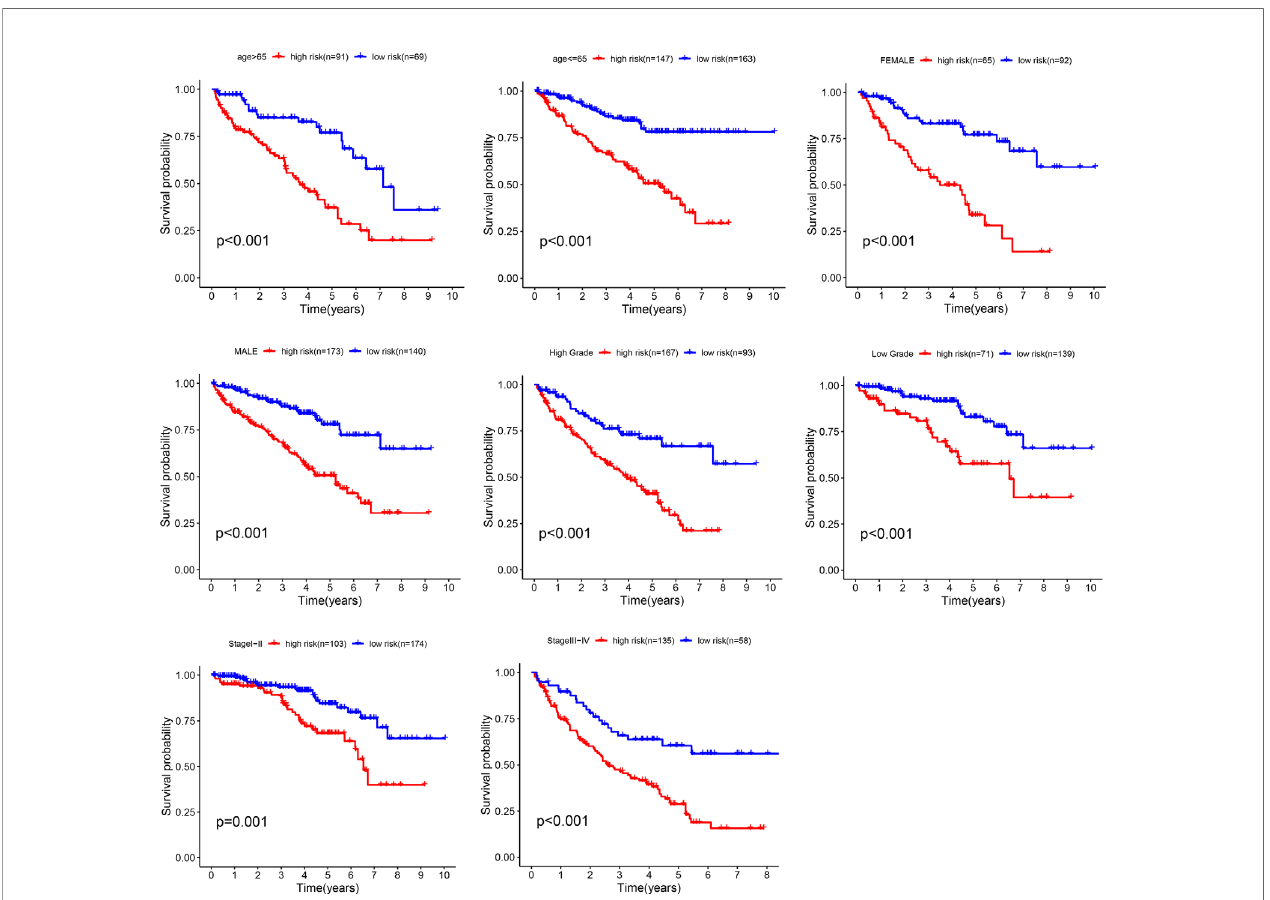
FIGURE 5 | Strati fi cation analyses. Survival curve analysis showed the OS rates of the high-risk and low-risk groups strati fi ed by age, gender, grade and